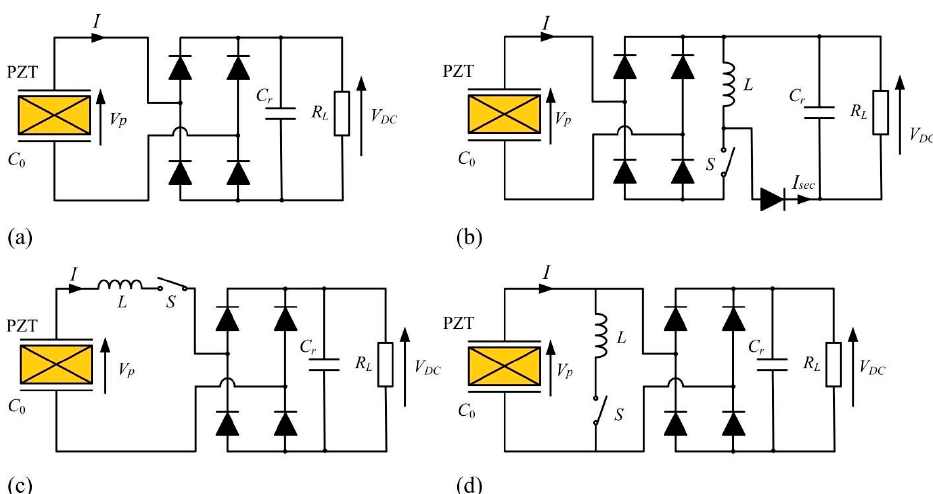
Figure 1. Energy-extraction circuits: ( a ) standard circuit; ( b ) SECE circuit; ( c ) serial SSHI circuit; ( d ) parallel SSHI circuit.